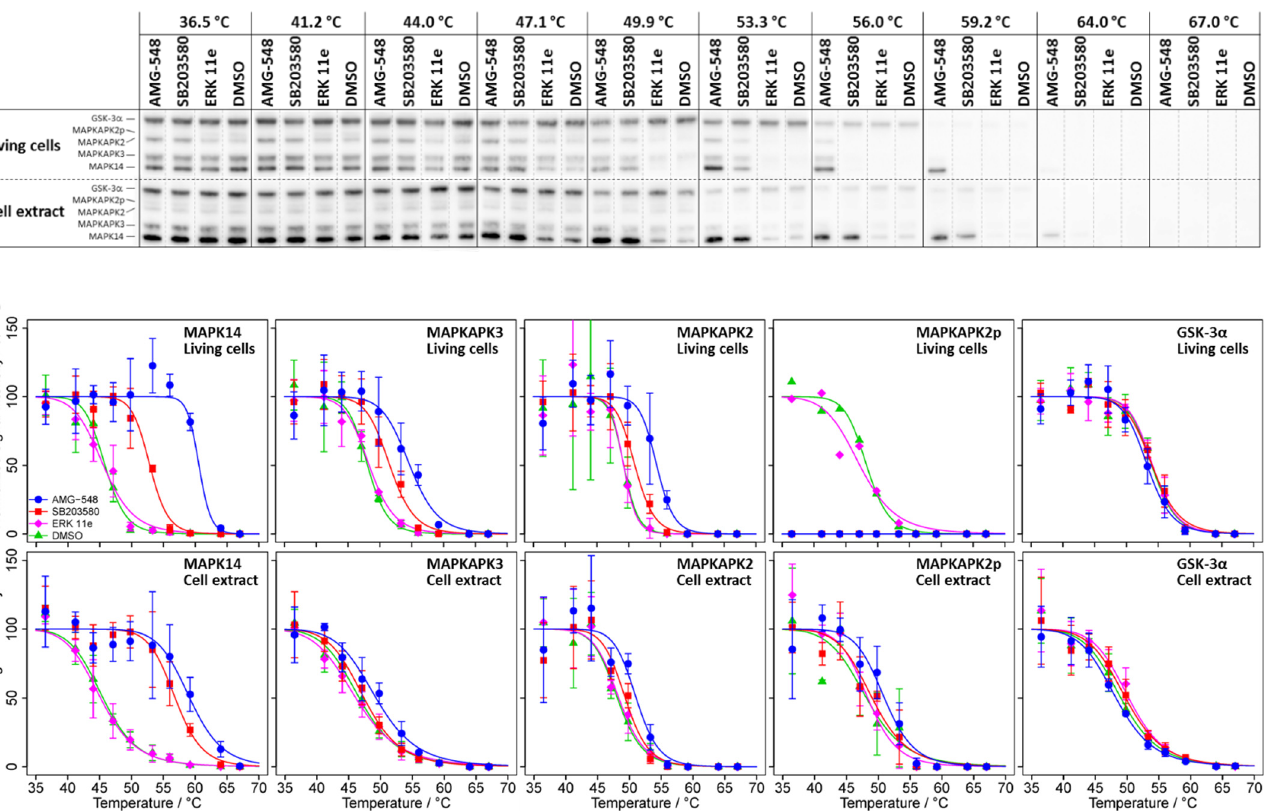
Figure 1. CETSA experiments for a temperature range between 36.5 and 67.0 ◦ C without inhibitor (only DMSO) or at constant inhibitor concentrations of 20 µ M, respectively. ( a ) Immunoblots for one of the replicates of CETSA experiments for living cells and cell extract, respectively. ( b ) Melting curves (solid lines) derived from integrated, normalized, and fitted signal intensities from the immunoblots. Datapoints and error bars represent means over the replicates +/ − one standard deviation. Melting points and other parameters including the number of replicates are summarized in Table